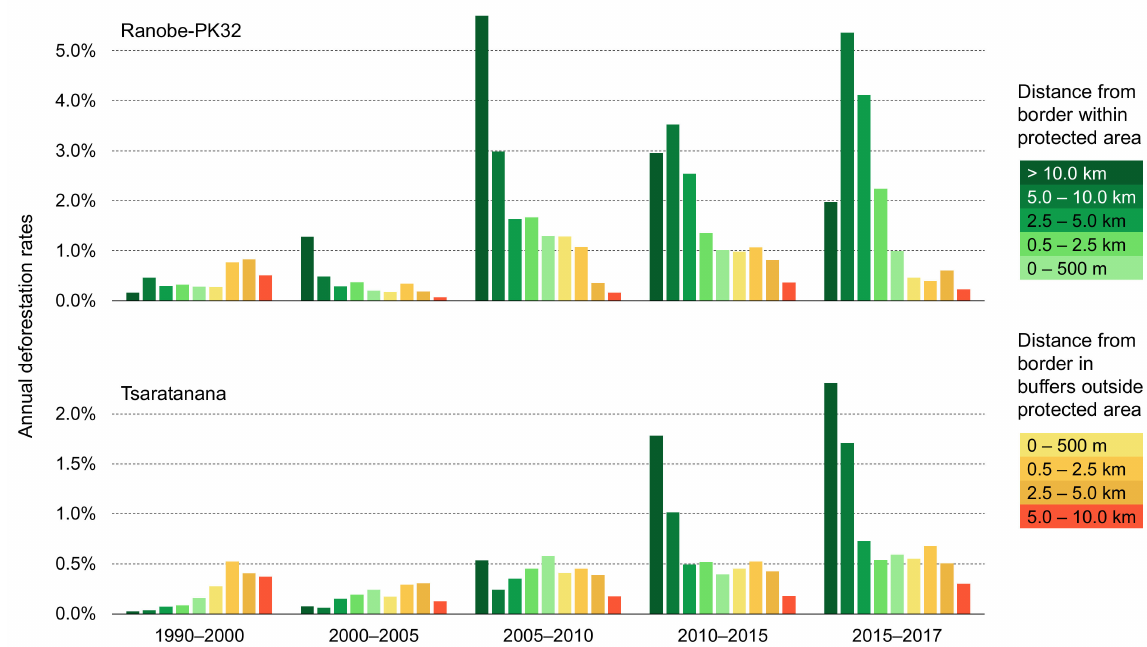
Figure 4. Annual deforestation rates in the two larger case study sites and their buffers according to their distance to PA borders. (Pattern as in Figure